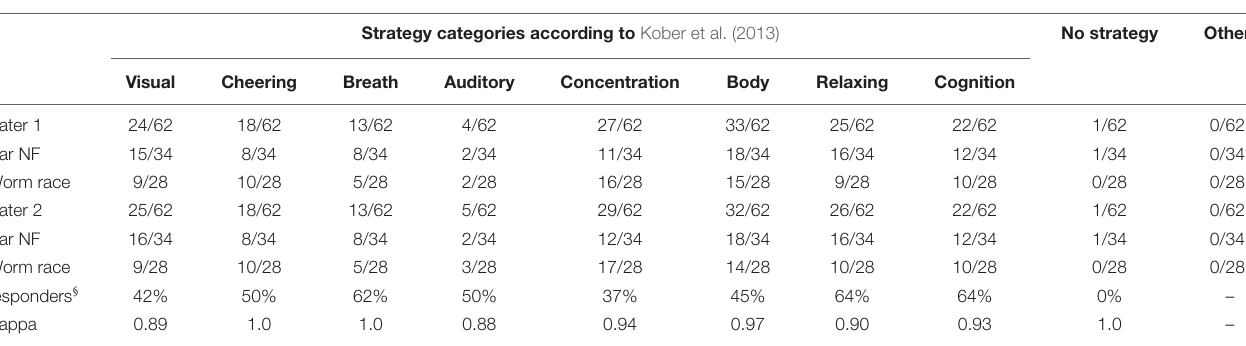
TABLE 2 | Frequency of occurrence of the different